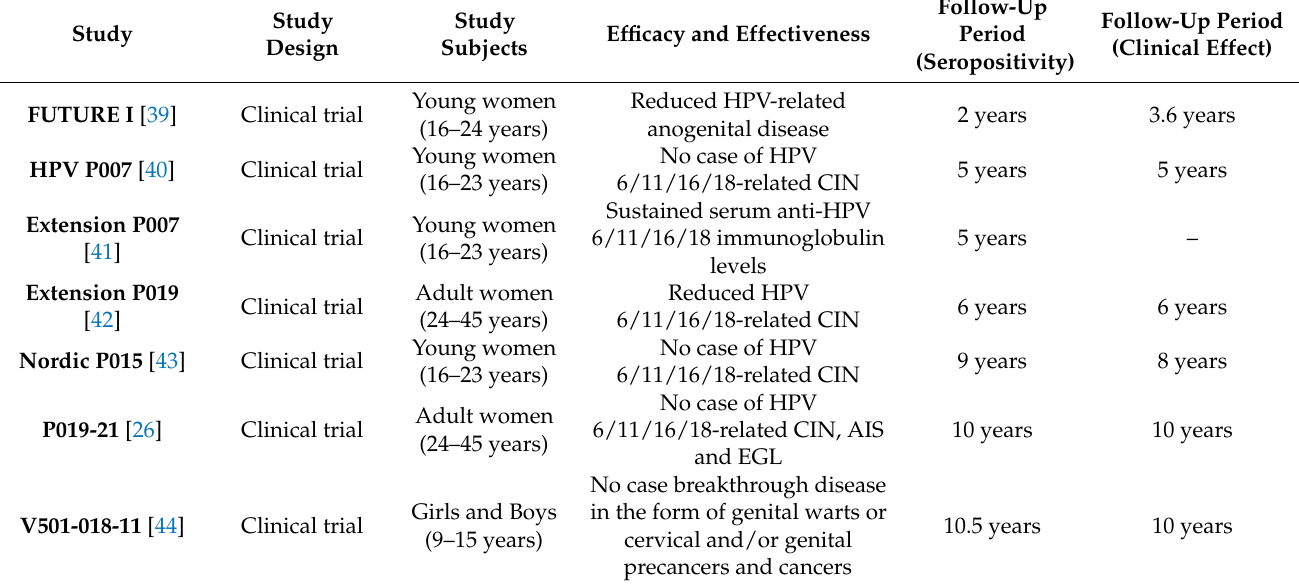
Table 3. Long-term effect on 4-valent